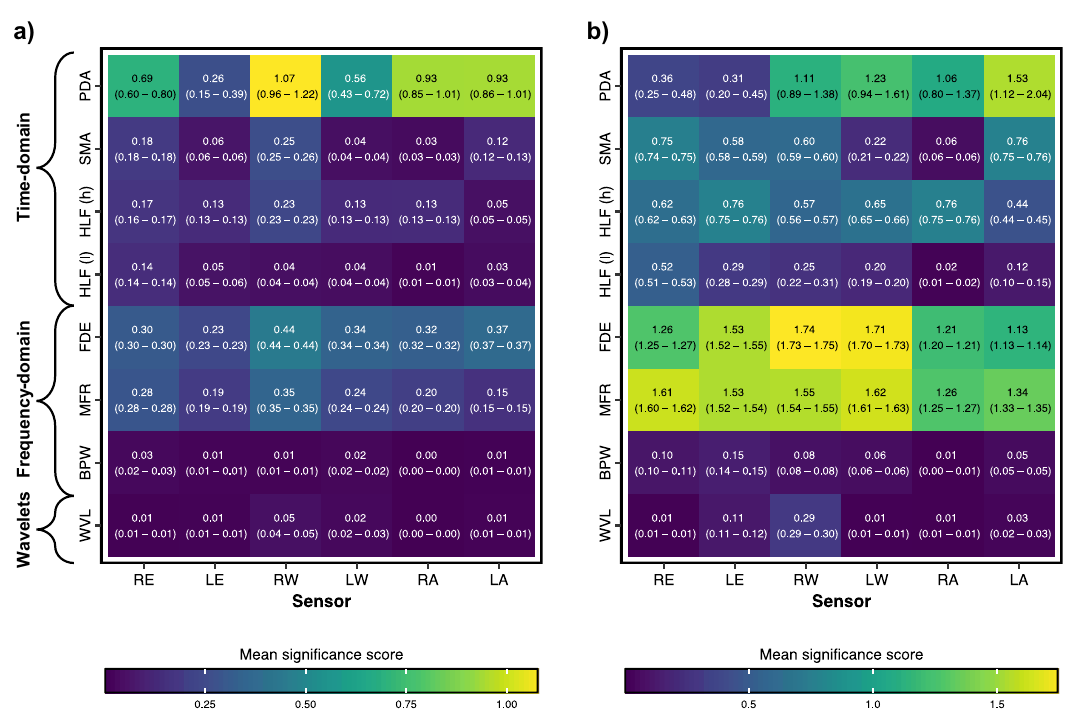
Figure 4. Feature significance matrices of optimally discriminating motor function detection and functional outcome prediction models. Significance scores are calculated by weighting linear optimal low-rank projection (LOL) coefficients of sensor-feature type combinations—which represent the relative importance of each timestep of each sensor-feature type combination in explaining the variance in the dataset stratified by ( a ) the motor component score of the Glasgow Coma Scale (GCSm) or ( b ) the Glasgow Outcome Scale–Extended (GOSE)—by the logistic regression coefficients of the corresponding LOL component in the low-dimensional vector (Fig. 1b). The higher (yellow) the mean significance score, the greater the combination of that sensor- feature type combination in the learned discrimination of patients at that threshold. The feature significance matrix in ( a ) corresponds to the optimally discriminating model configuration (6-h observation window) for detection of GCSm > 4 (Fig. 2a) while the matrix in ( b ) corresponds to the optimally discriminating model configuration (6-h observation window) for prediction of GOSE > 5 at hospital discharge (Fig. 3a). Mean significance scores (across all timesteps for a sensor-feature type combination) are listed as well as 95% confidence intervals bootstrapped from 1000 resamples to represent the variation across repeated cross-validation folds (5 repeats of 5 folds) and nine missing value imputations. Sensor placement acronyms correspond to joints shown in Fig. 1 and feature type acronyms are decoded in Table